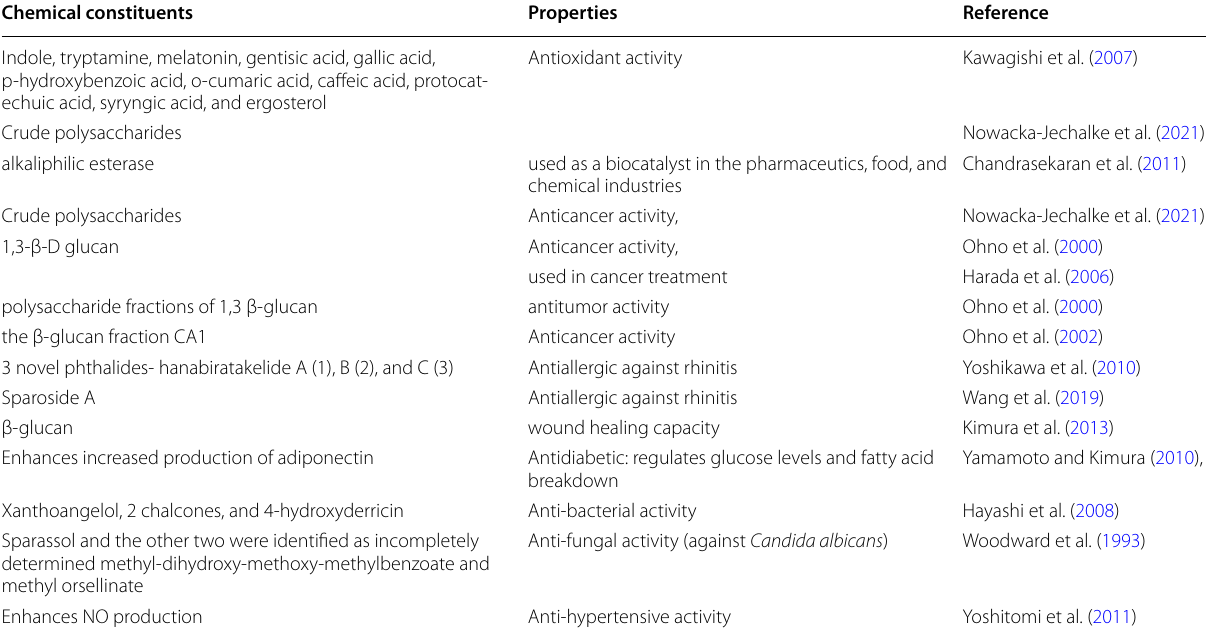
Table 2 Medicinal properties of different chemical constituents present in S. crispa Chemical